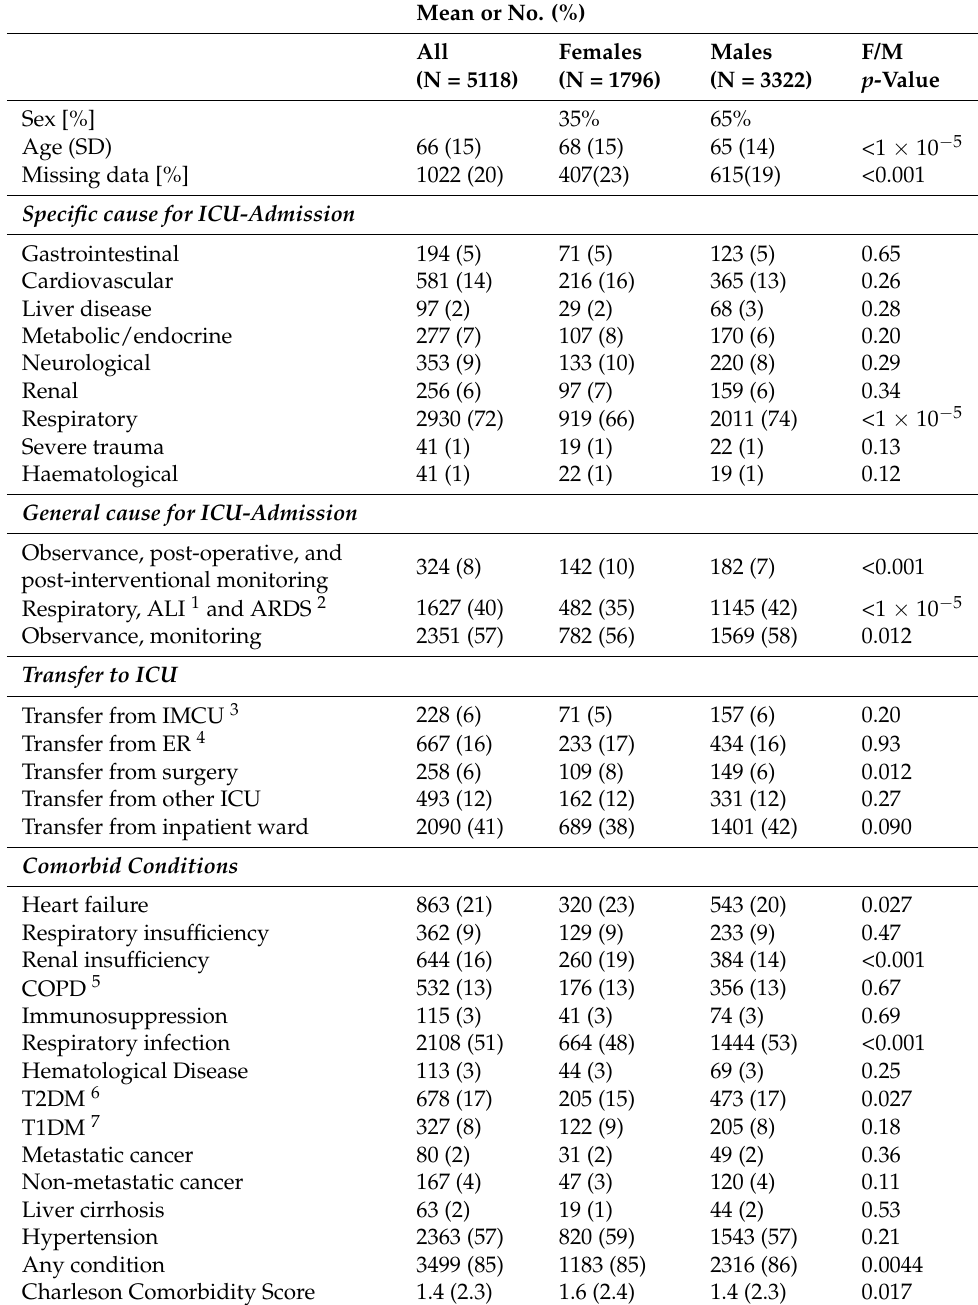
Table 1. Comparison of patients with Coronavirus Disease 2019 admitted to the intensive care unit (ICU), by sex. Pre-ICU characteristics. The number of patients with observed characteristics for categorical variables or mean value for continuous variables are shown as well as the relative numbers (%) or standard deviation (SD) in parentheses. p -value significance tests between values of both sexes are performed using Chi-squared test for categorical variables or t -test for continuous